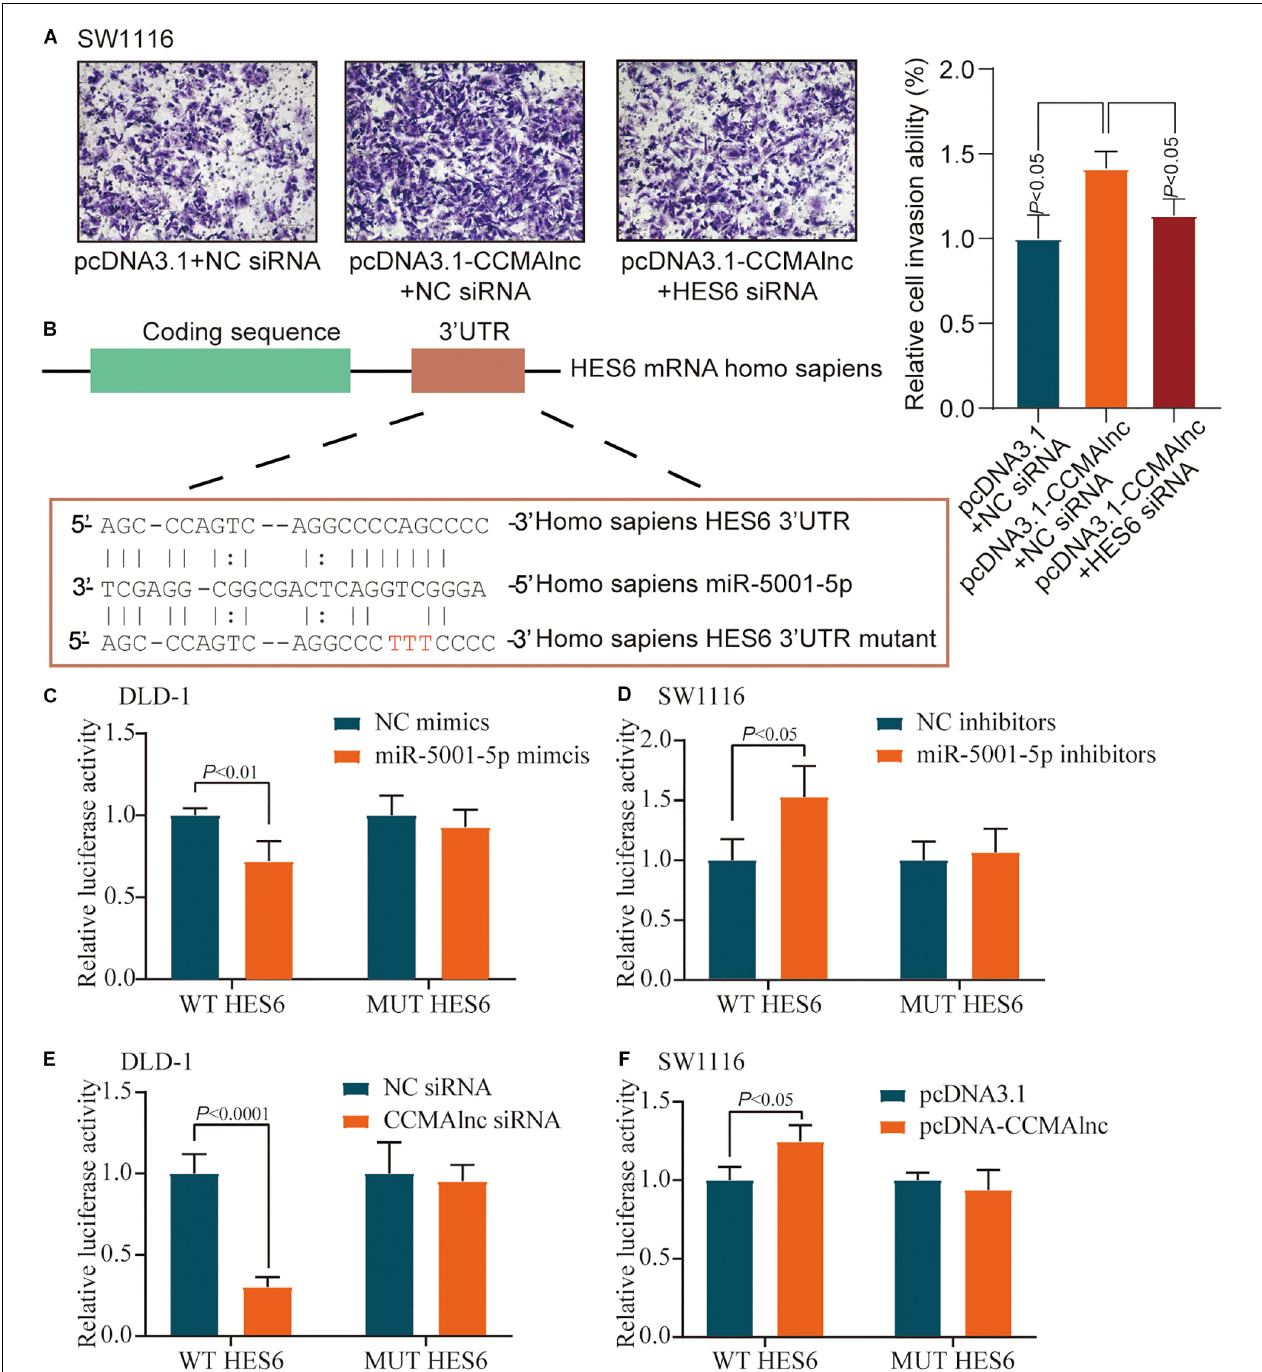
FIGURE 5 | miR-5001-5p targets the 3 (cid:48) -UTR of HES6 mRNA. (A) A Matrigel invasion assay was performed in SW1116 cells after transfection of control vector or CCMAlnc overexpression vector combined with HES6 siRNA. The invading cell numbers on each filter were counted. Data were plotted by defining the percentage of control cells as 100%. N = 3. Scale bars, 50 µ m. (B) One of the predicted binding sites of miR-5001-5p with the 3 (cid:48) -UTR of HES6 mRNA. (C) Luciferase reporters containing HES6-3 (cid:48) -UTR or HES6-3 (cid:48) -UTR-mutant were cotransfected into DLD-1 cells with miR-5001-5p mimics or miR-5001-5p inhibitors. Luciferase activities were detected after 48 h. (D) Luciferase reporters containing HES6-3 (cid:48) -UTR or HES6-3 (cid:48) -UTR-mutant were cotransfected into SW1116 cells with miR-5001-5p inhibitors. Luciferase activities were detected after 48 h. (E) Luciferase reporters containing HES6-3 (cid:48) -UTR or HES6-3 (cid:48) -UTR-mutant were cotransfected into DLD-1 cells with CCMAlnc siRNA. Luciferase activities were detected after 48 h. (F) Luciferase reporters containing HES6-3 (cid:48) -UTR or HES6-3 (cid:48) -UTR-mutant were cotransfected into SW1116 cells with CCMAlnc overexpression vector. Luciferase activities were detected after 48 h.